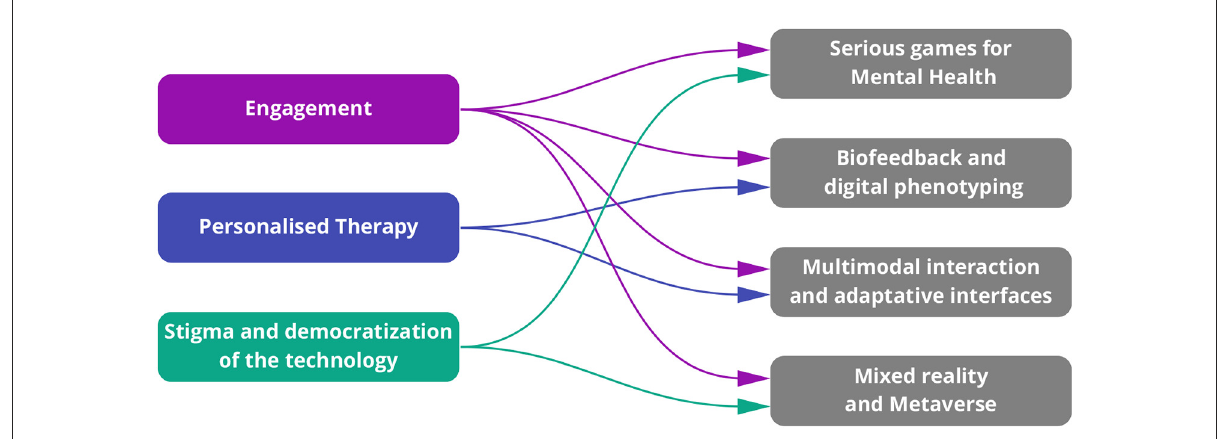
FIGURE1 Relationships between challenges and opportunities in XR technologies for mental